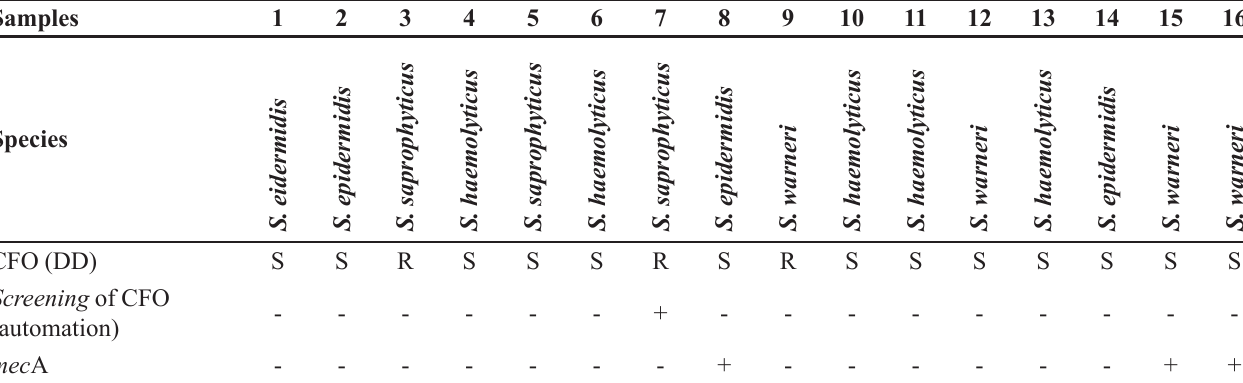
TABLE II - Analysis of MRCoNS of the 16 coagulase-negative staphylococci isolates from Platelet Concentrates through the phenotypic tests of Cefoxitin Disk Diffusion (DD), screening of cefoxitin by VITEK ® 2, research of the gene mec A by Polymerase Chain